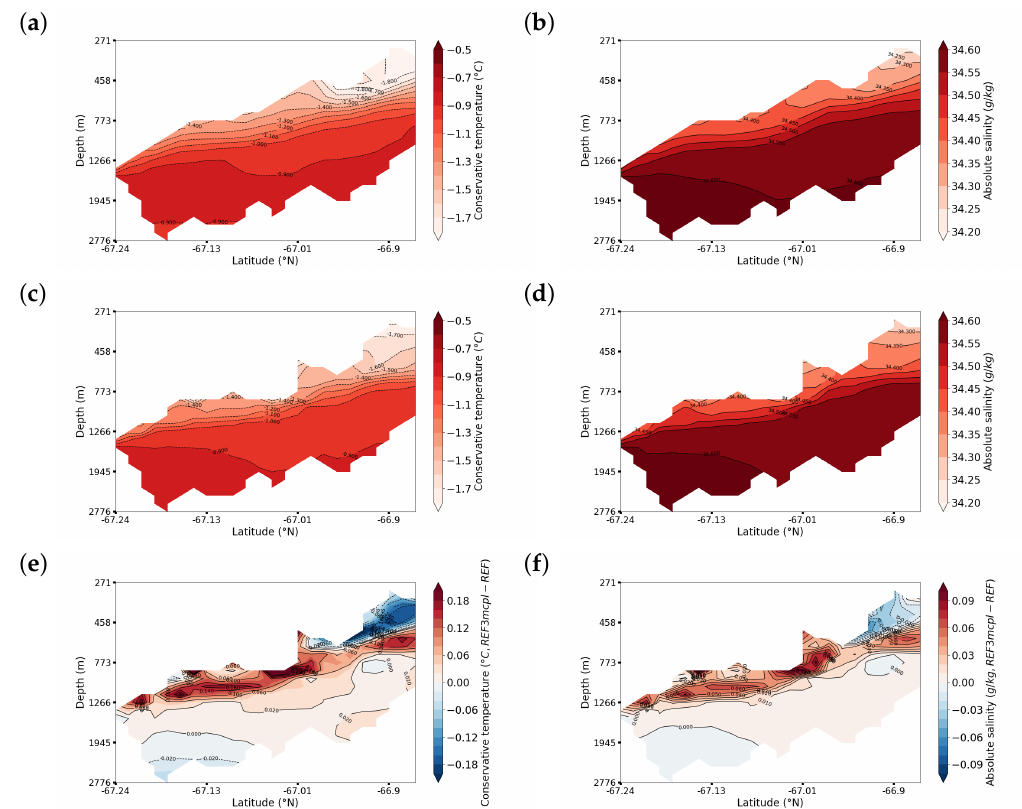
Figure A3. Cross-sections in the TIS cavity of ocean temperature for REF3mcpl ( a ) and REF ( c ), and of ocean temperature difference between REF3mcpl and REF ( e ). Cross-sections in the TIS cavity of ocean salinity for REF3mcpl ( b ) and REF ( d ), and of ocean salinity difference between REF3mcpl and REF ( f ). All averaged over the 20-year simulations. The section is shown in ( a ).